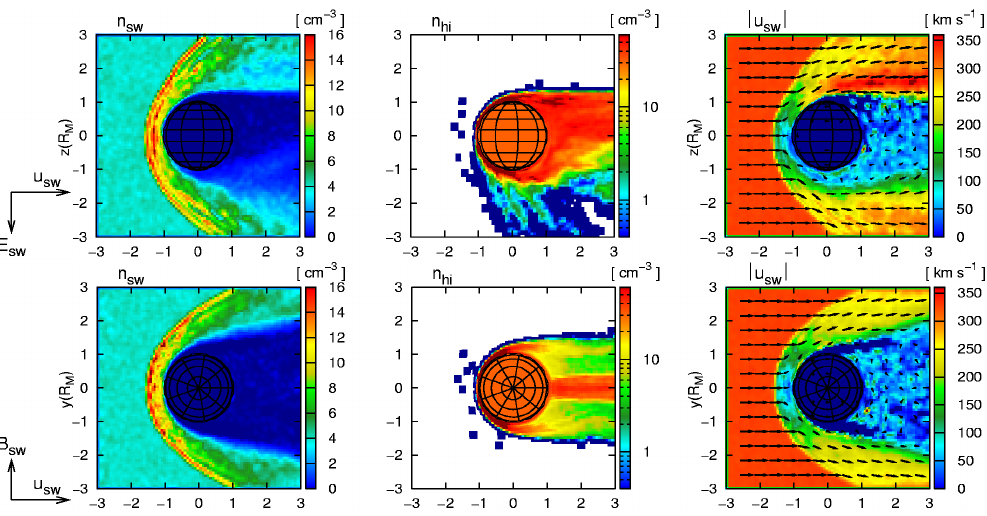
Fig. 6. Simulation results in the polar plane (top) and in the equator plane (bottom). The subfigures display from right to left the solar wind density ( n sw ), the heavy ion density ( n hi ) and the solar wind bulk velocity ( u sw ). Besides the bow shock in front of the obstacle an further boundary the ICB can be seen behind it. At this boundary the solar wind density goes down and the heavy ion density increase sharply. On the nightside the simulation results show a plasma sheet and density rays consisting of heavy ions.